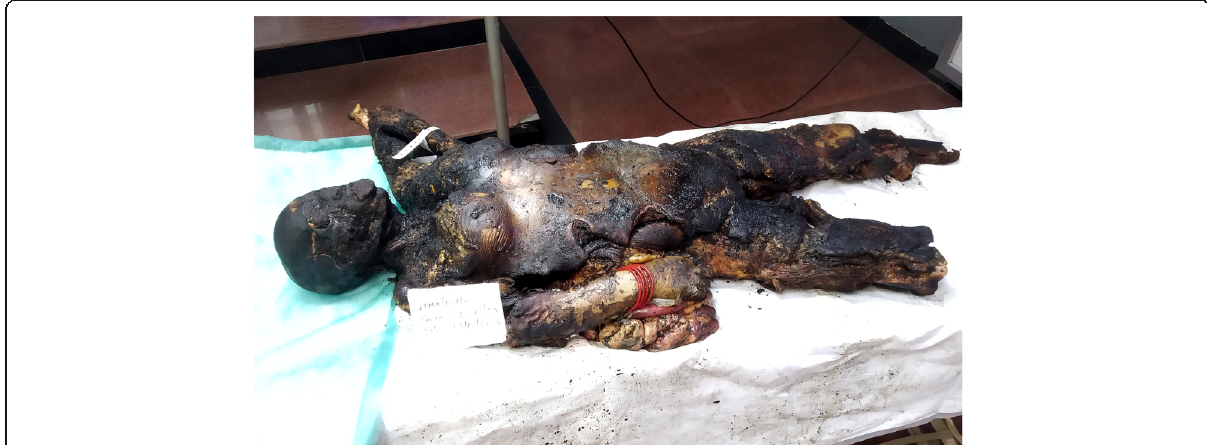
Fig. 1 Burnt and charred body with traumatic amputation of parts of lower limbs (case